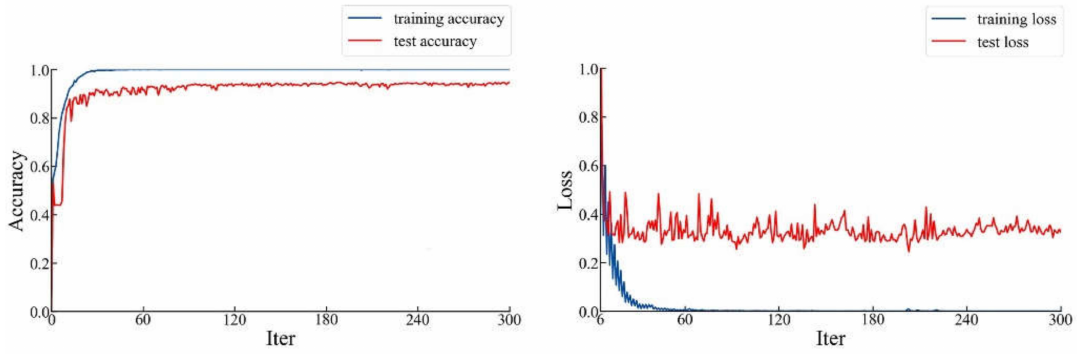
Figure 9. The accuracy and loss curve of the ResNet-101 + FPN transfer learning from the ImageNet classification